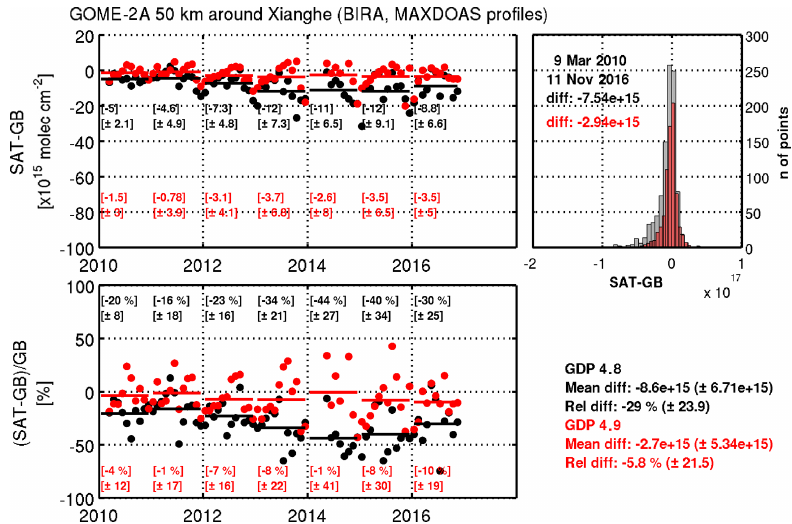
Figure 18. Absolute and relative differences of GOME-2A and MAXDOAS tropospheric NO 2 columns. The time series presents the monthly mean differences for GDP 4.8 (black) and GDP 4.9 (red). The total mean difference values and standard deviations are given, as well as the yearly values. The histogram presents the daily differences over the whole time series for the two products (grey for GDP 4.8 and red for GDP